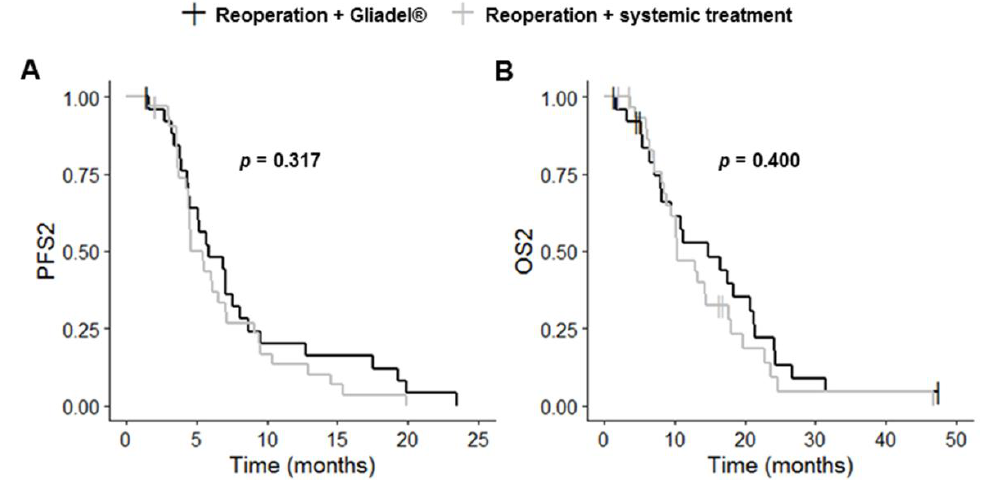
Figure 4. Kaplan–Meier curves for survival stratified for reoperation with Gliadel ® ( n = 26) and reoperation with systemic treatment ( n = 32) (( A ) PFS2; ( B ) OS2). Abbreviations: OS2, overall survival after first progression; PFS2, progression-free survival after first progression.